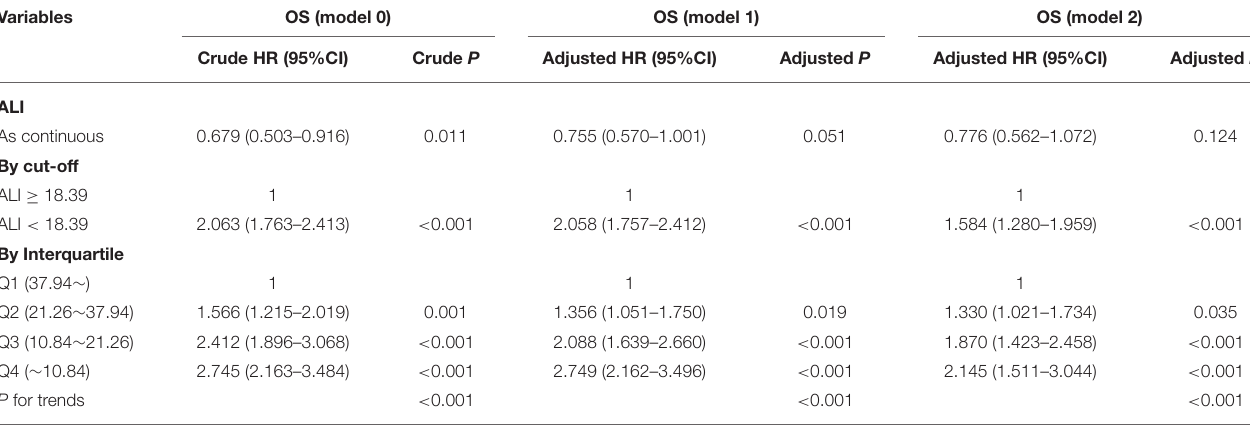
TABLE 2 | Univariate and multivariate analysis of the OS in patients with cancer sarcopenia. Variables